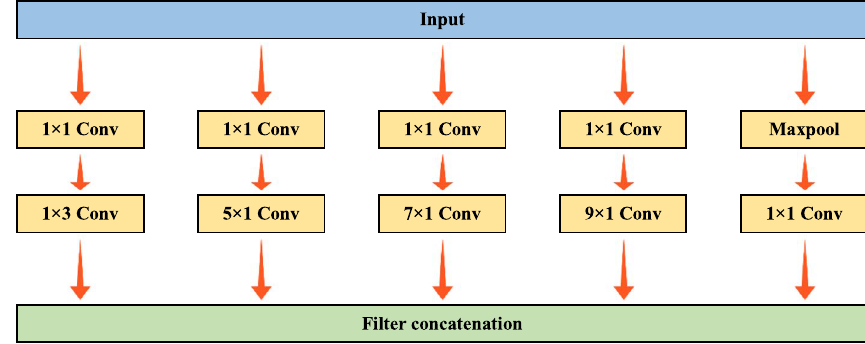
Fig. 1 The one-dimensional multi-scale convolutional